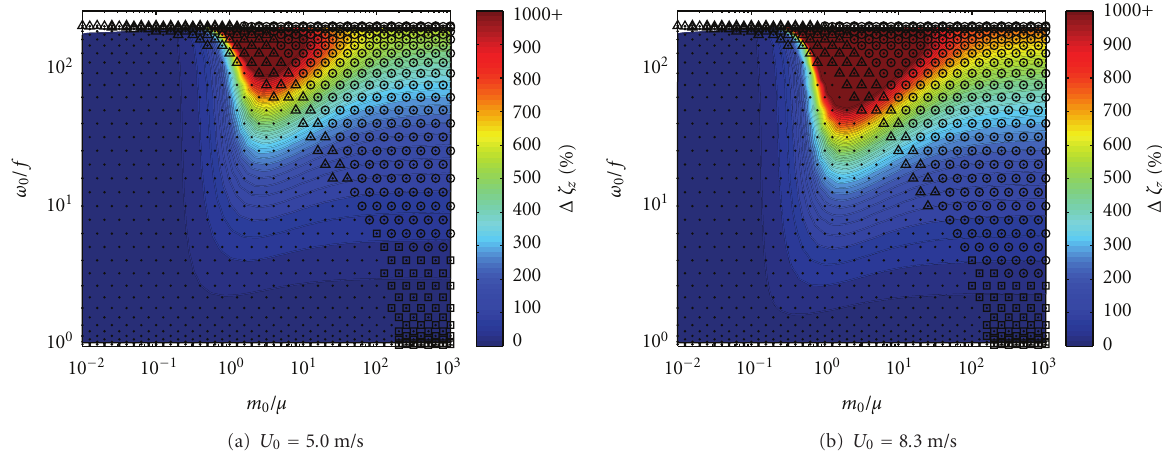
Figure 4: Contours of percentage changes in short wave steepness and symbols for expected turning points (green triangles), critical levels (red squares), and both (white circles).